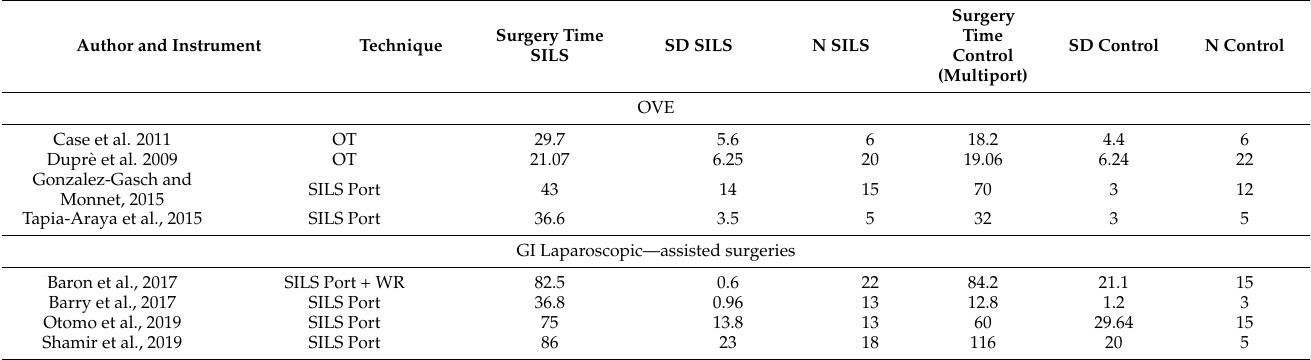
Table 3. Data extracted for meta-analysis. (OVE: Ovariectomy; GI: Gastrointestinal).